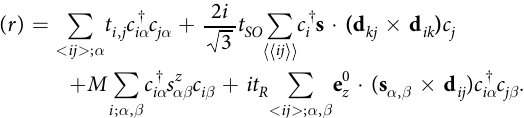
Figure 1. The honeycomb lattice geometry. The lattice structure of graphene is made out of two interpenetrating triangular lattices ( a 1 and a 2 are the lattice unit vectors). The nearest-neighbor vectors are δ (cid:31)(cid:30) and δ . The armchair edge is at the x direction, and Strain is along the y 3